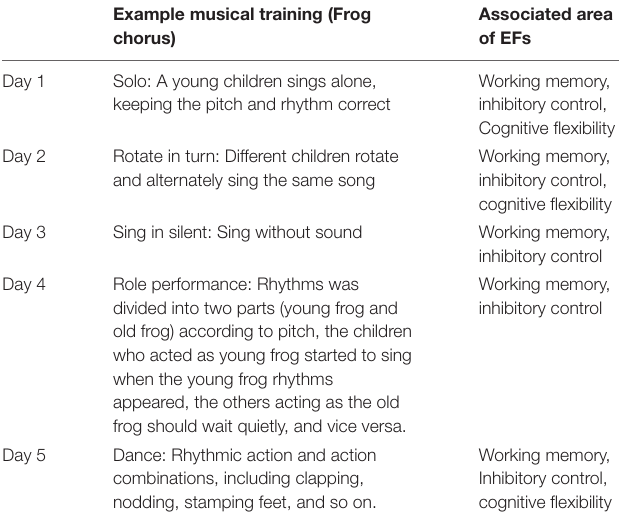
TABLE 4 | Examples of music activities included in the intervention and associated areas of EFs (Tenth week). Example musical training (Frog